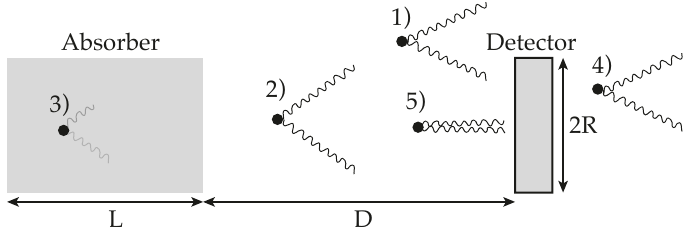
Figure 10 . Different scenarios for the ALPs to decay invisibly (here schematically shown for